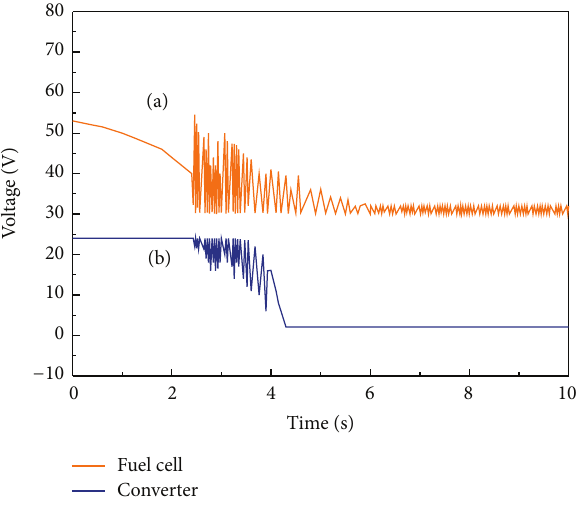
Figure 11: Variation of fuel cell stack voltage and DC-DC converter voltage in presence of external